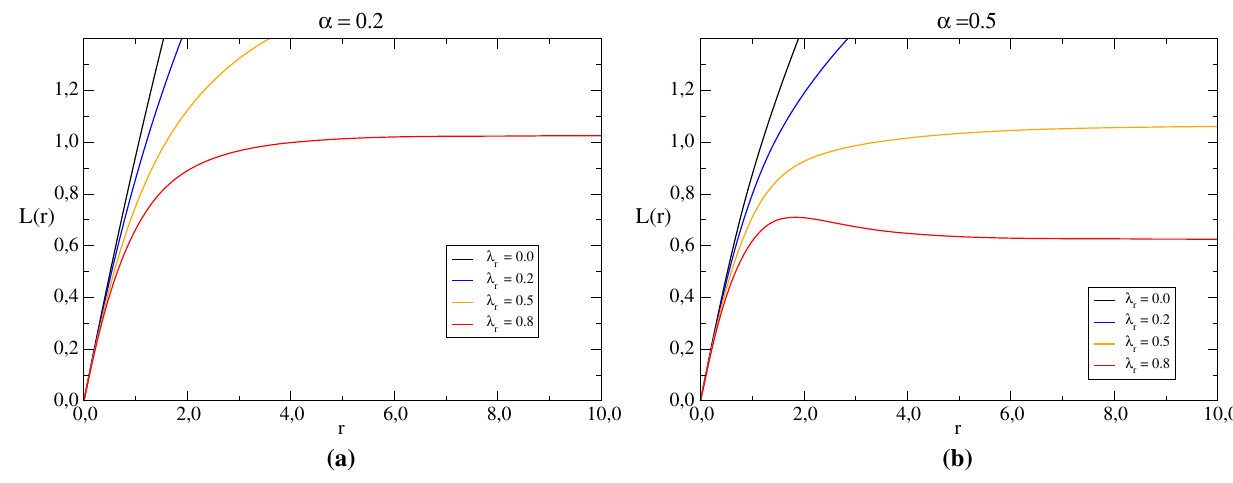
Fig. 3 The comparison between the behavior of the metric function L as functions of r . In the left panel considering α = 0 . 2 and the right panel considering α = 0 . 5. In both plots we cover the cases λ r = 0 . 0 , 0 . 2 , 0 . 5 , 0 .